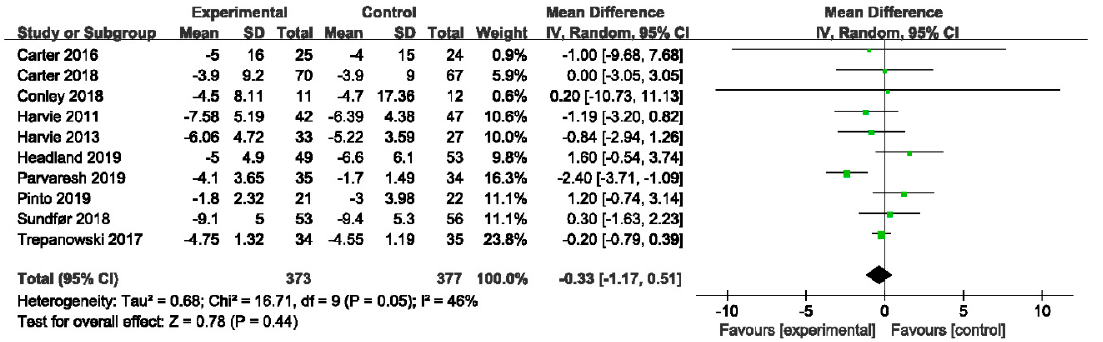
Figure 3. Forest plot for body weight in trials that compared IER with CER. Abbreviations: CI, confidence interval; IER, intermittent energy restriction; CER, continuous energy restriction. The unit of mean difference in body weight is kg.